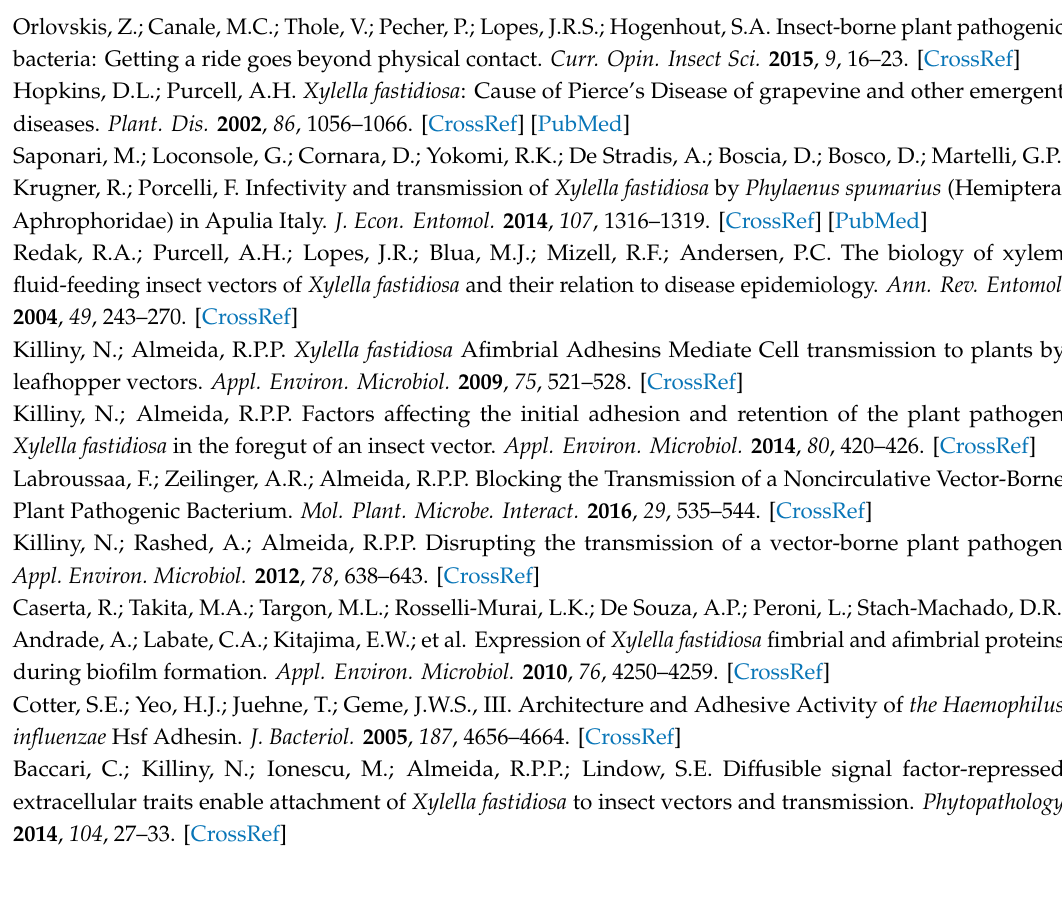
Figure S1: Wings of sharpshooters: Bucephalogonia xanthophis , Macugonalia leucomelas and Sibovia sagata after incubation in XFM- ∆ medium with and without Xylella fastidiosa modified with the green fluorescent protein (GFP) gene, Figure S2: Fluorescence of the biofilm formed by Xylella fastidiosa fused to the green fluorescent protein (GFP), after 10 days of incubation at 28 ◦ C in XFM- ∆ medium containing as adhesion substrate biotic ( Macugonalia leucomelas wing) and abiotic (coverslip) surfaces, Table S1: Mortality rates of adults of the sharpshooter Macugonalia leucomelas after feeding for 6 h on artificial diets with cell suspensions of Xylella fastidiosa , supplemented with increasing concentrations of the antibody against XadA2